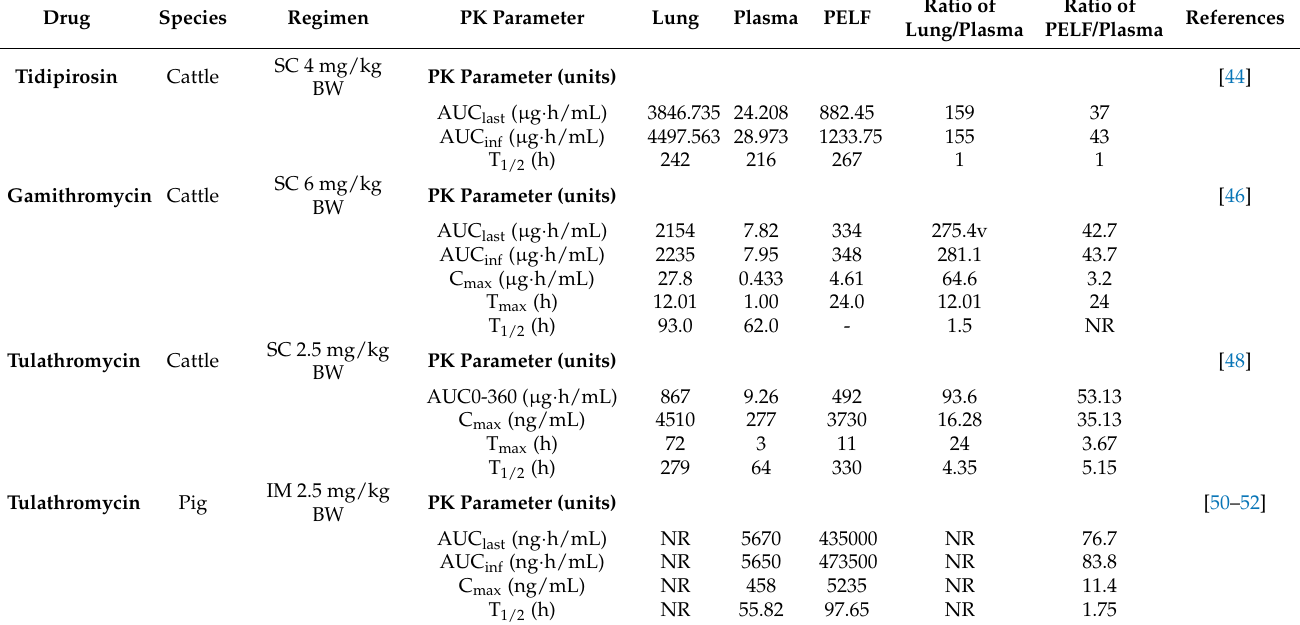
Table 1. Summary of selected PK parameters determined based on mean macrolide antibiotic concentrations in plasma, lung, and pulmonary epithelial lining fluid (PELF).